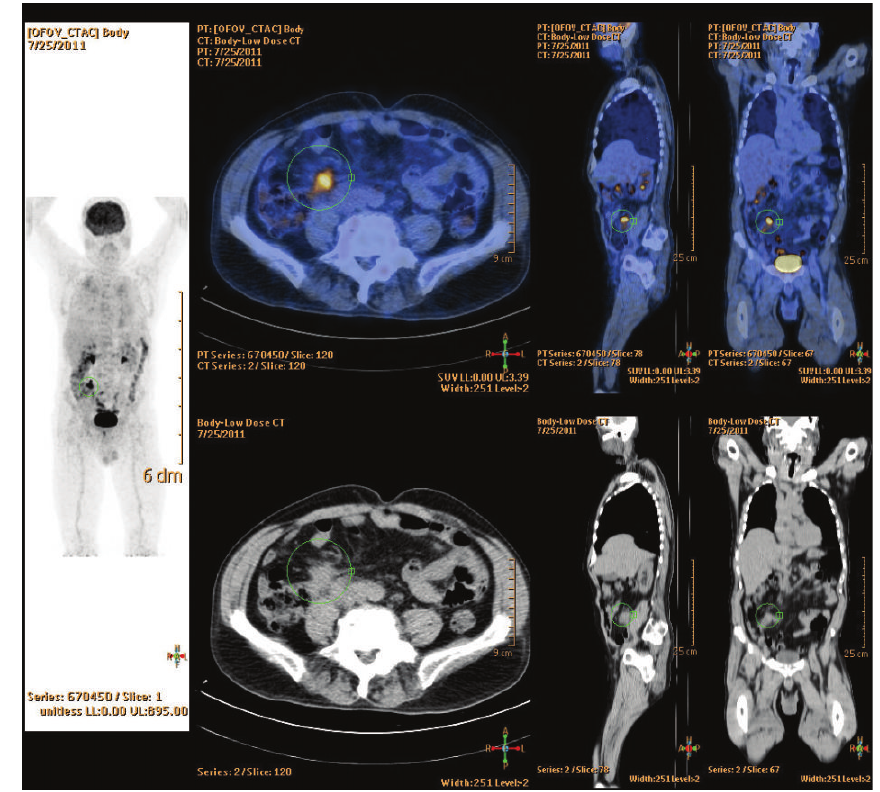
Figure 3: F-18 FDG PET/CT showing enhancement and intense abnormal tracer uptake focus in the appendiceal nodule in front of the right psoas